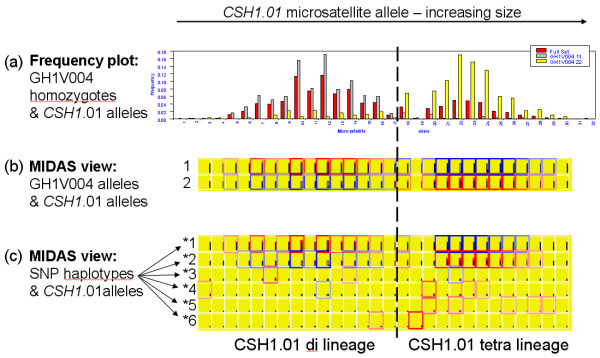
LD between a complex microsatellite and SNPs. (a) Previous work [22] indicated SNP alleles in LD with two size ranges of the CSH1.01 microsatellite. The lower size range has dinucleotide spacing, the upper has tetranucleotide spacing. This suggested two major lineages. (b) Plotting interallelic LD between a SNP (GH1V004) and the CSH1.01 microsatellite demonstrates clear LD with the two lineages. The common SNP alleles associate with the lower size range and the rare SNP alleles associate with the upper size range. Results are boxed in red where the haplotype frequency is significantly higher than expected (D' ≥ 0) and blue where it is significantly lower (D'<0). (c) SNP haplotypes (four SNPs, including GH1V004) confirm these findings and demonstrate the ability of MIDAS to handle haplotype data as a multi-allelic marker.